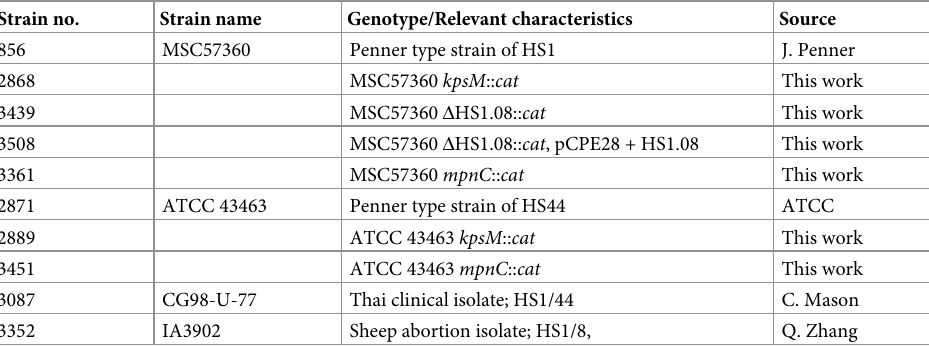
Table 1. Strains used in this work. Strain